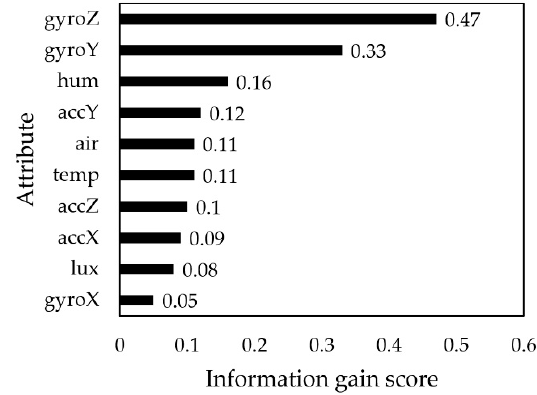
8 Figure 4. Hybrid fault model using density based spatial clustering of applications with noise (DBSCAN) outlier detection, synthetic minority oversampling technique (SMOTE) class balancing and random forest (RF) classification model. We collected an experimental dataset during initial implementation to evaluate performance of the proposed model. The collected dataset included 614 instances (378 normal and 236 abnormal), each with 10 attributes as follows: •